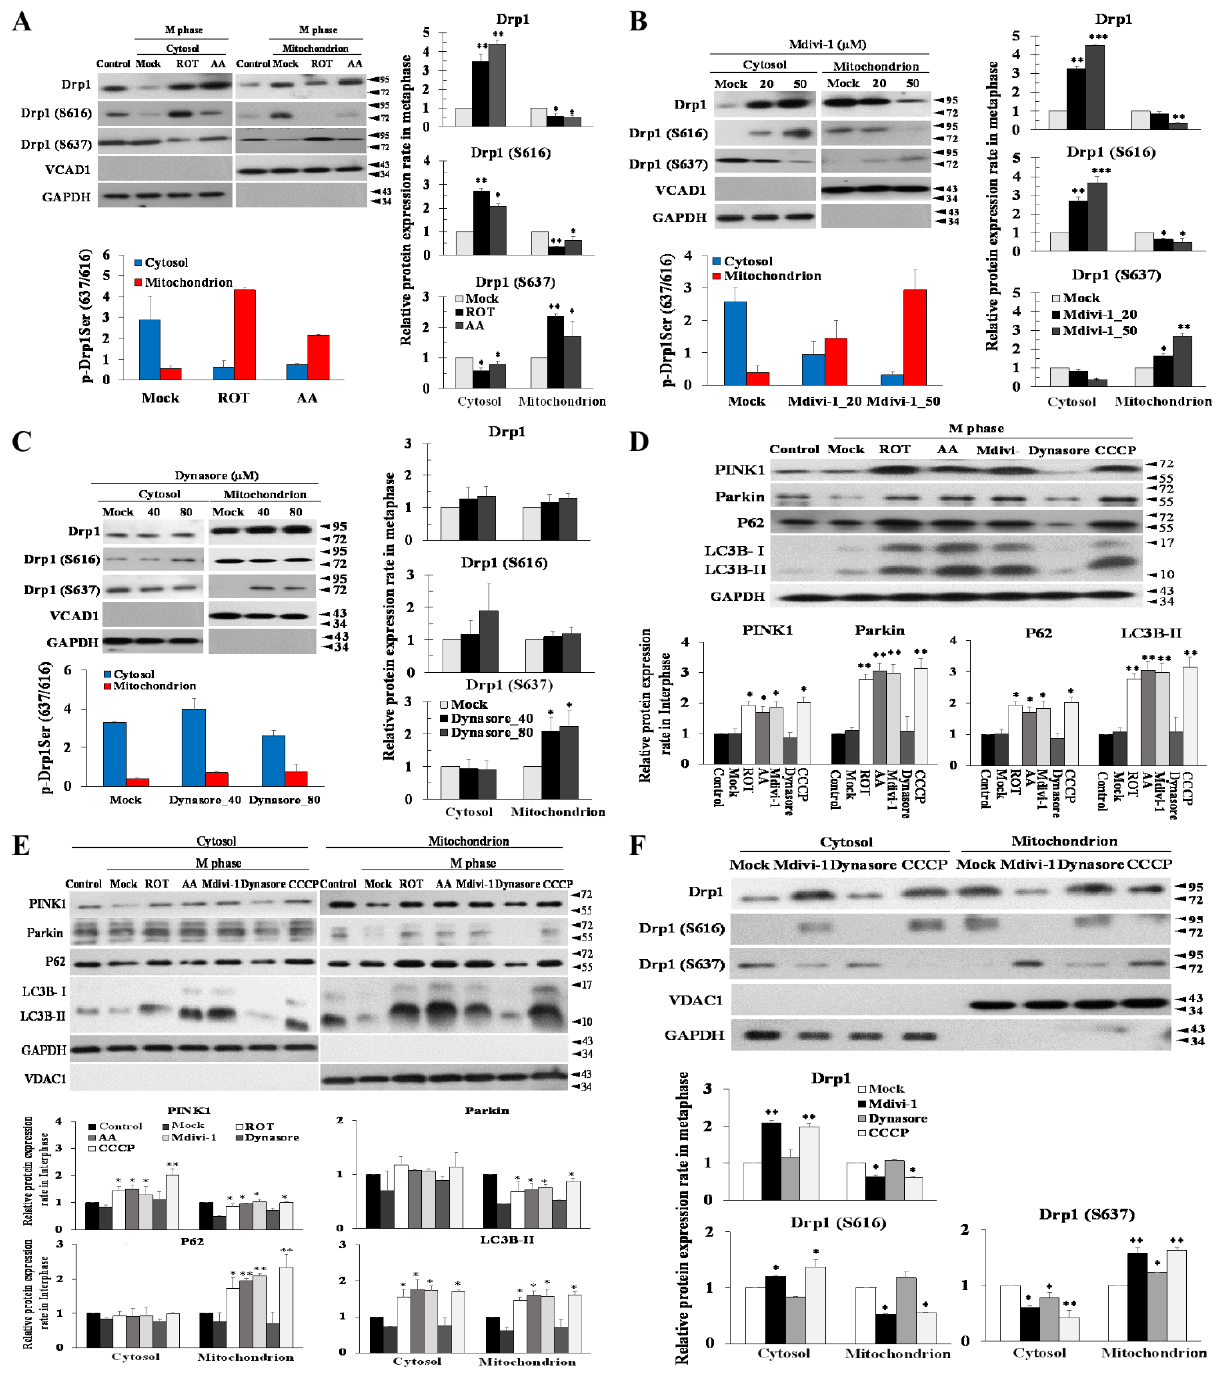
Figure 6. Blockade of mitochondrial ETC results in phosphorylation of mito-Drp1 Ser-637, which is essential for the PINK1/Parkin pathway to regulate mitophagy. ( A ) ROT or AA decreased Drp1-dependent mitochondrial fission. ( B ) Mdivi-1 decreased Drp1-dependent mitochondrial fission. ( C ) Dynasore is not a specific Drp1 inhibitor. Levels of total Drp1, Drp1-Ser616, and Drp1-Ser637 were checked in cytoplasmic and mitochondrial fractions in M phase with ROT, AA, Mdivi-1, and Dynasore for 24 h. ( D ) ROT, AA, and Mdivi-1 treatments can upregulate expression of Parkin and promote mitophagy in M-phase arrest. ( E ) Levels of PINK1/Parkin, P62, and LC3B were checked in cytoplasmic and mitochondrial fractions in M phase with ROT, AA, Mdivi-1, and Dynasore. ( F ) CCCP decreased Drp1-dependent mitochondrial fission. VDAC1 was assessed as an internal loading control. GAPDH was checked for subcellular purity. The bar graph represents the mean of triplicates ± SD. * p < 0.05, ** p < 0.01, *** p < 0.001 compared with the control group and Mock group.